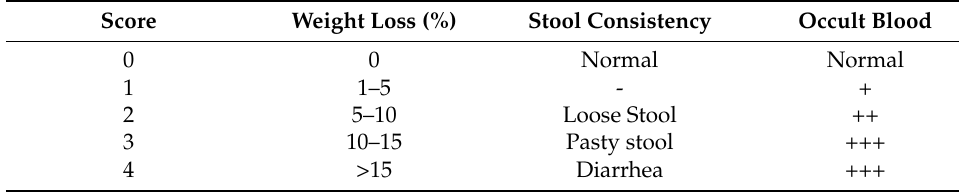
Table 1. Scoring method of the disease activity index in the four study groups.